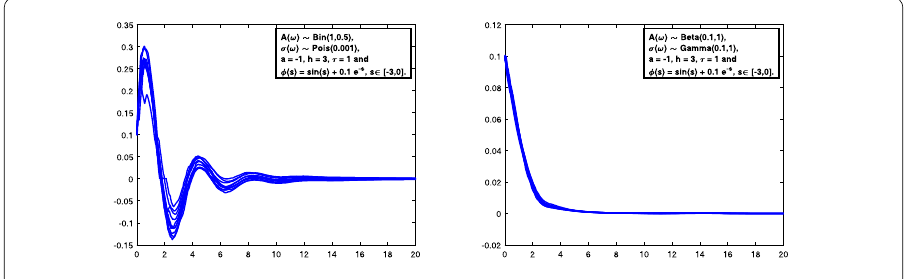
Figure 8 Stable trajectories of the solution x = 0 of (37)